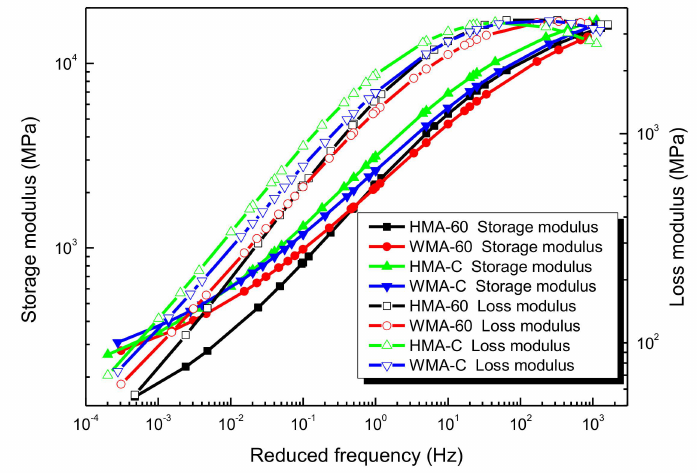
Figure 19. Storage modulus and loss modulus of the asphalt mixtures